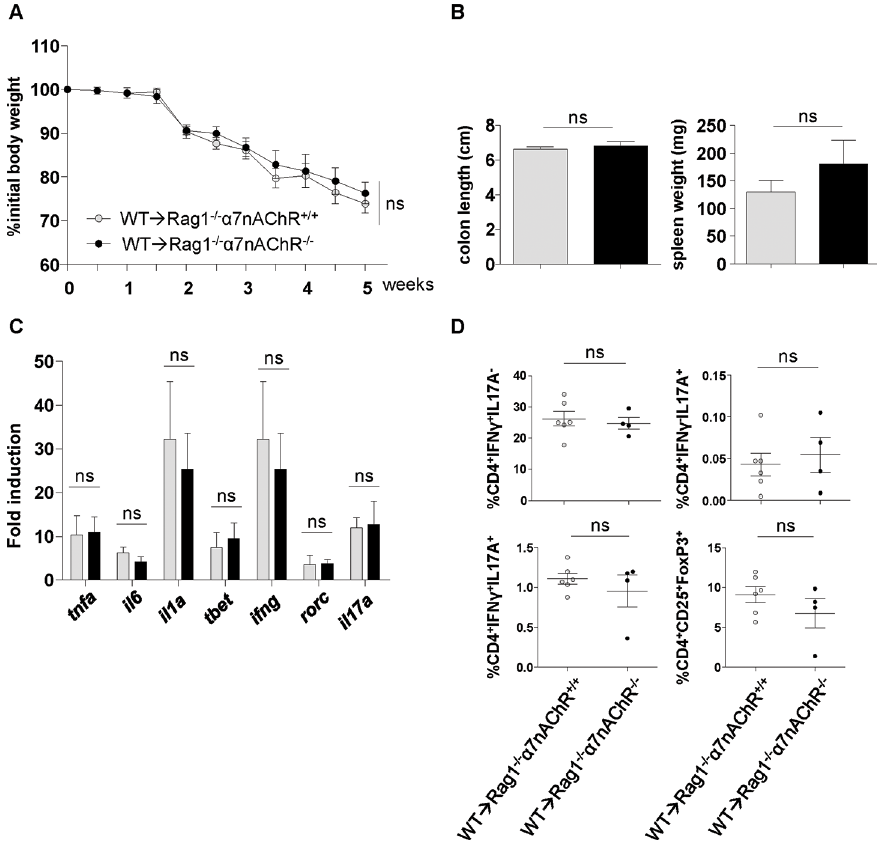
Figure 7. Severity of T cell transfer induced colitis is independent of α 7nAChR signaling. Naïve T cells isolated by cell sorting from WT mice, were adoptively transferred i.p . in Rag1 -/- α 7nAChR -/- or Rag1 -/- α 7nAChR +/+ littermates control mice. (A) Body weight loss was assessed twice per week. Statistical significance was determined using a multivariate linear model after a post-hoc Bonferroni-Holm correction for body weight changes and stool consistency score (ns, not significant). (B) Five weeks after adoptive transfer, mice were sacrificed and disease severity was additionally assessed by means of colon length and spleen weight. (C) Inflammatory gene expression was measured by q-PCR in the colon. Gene expression levels are shown relative to rpl32 mRNA expression. (D) Frequencies and numbers of T helper cell and Treg subsets were assessed in the colon by flow cytom- etry. Dots represent individual mice. Data expressed as mean ± SEM are representative of 3 independent experiments. Statistical significance was determined with the unpaired Student t-test for colon length, spleen weight, gene expression level and flow cytometry analysis (ns, not